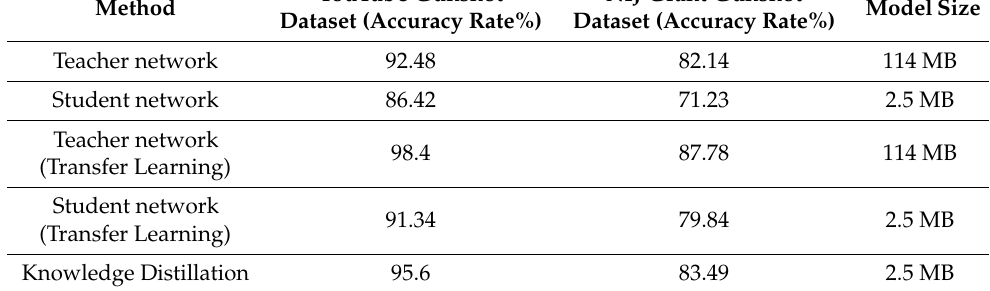
Table 5. Ablation experiment.